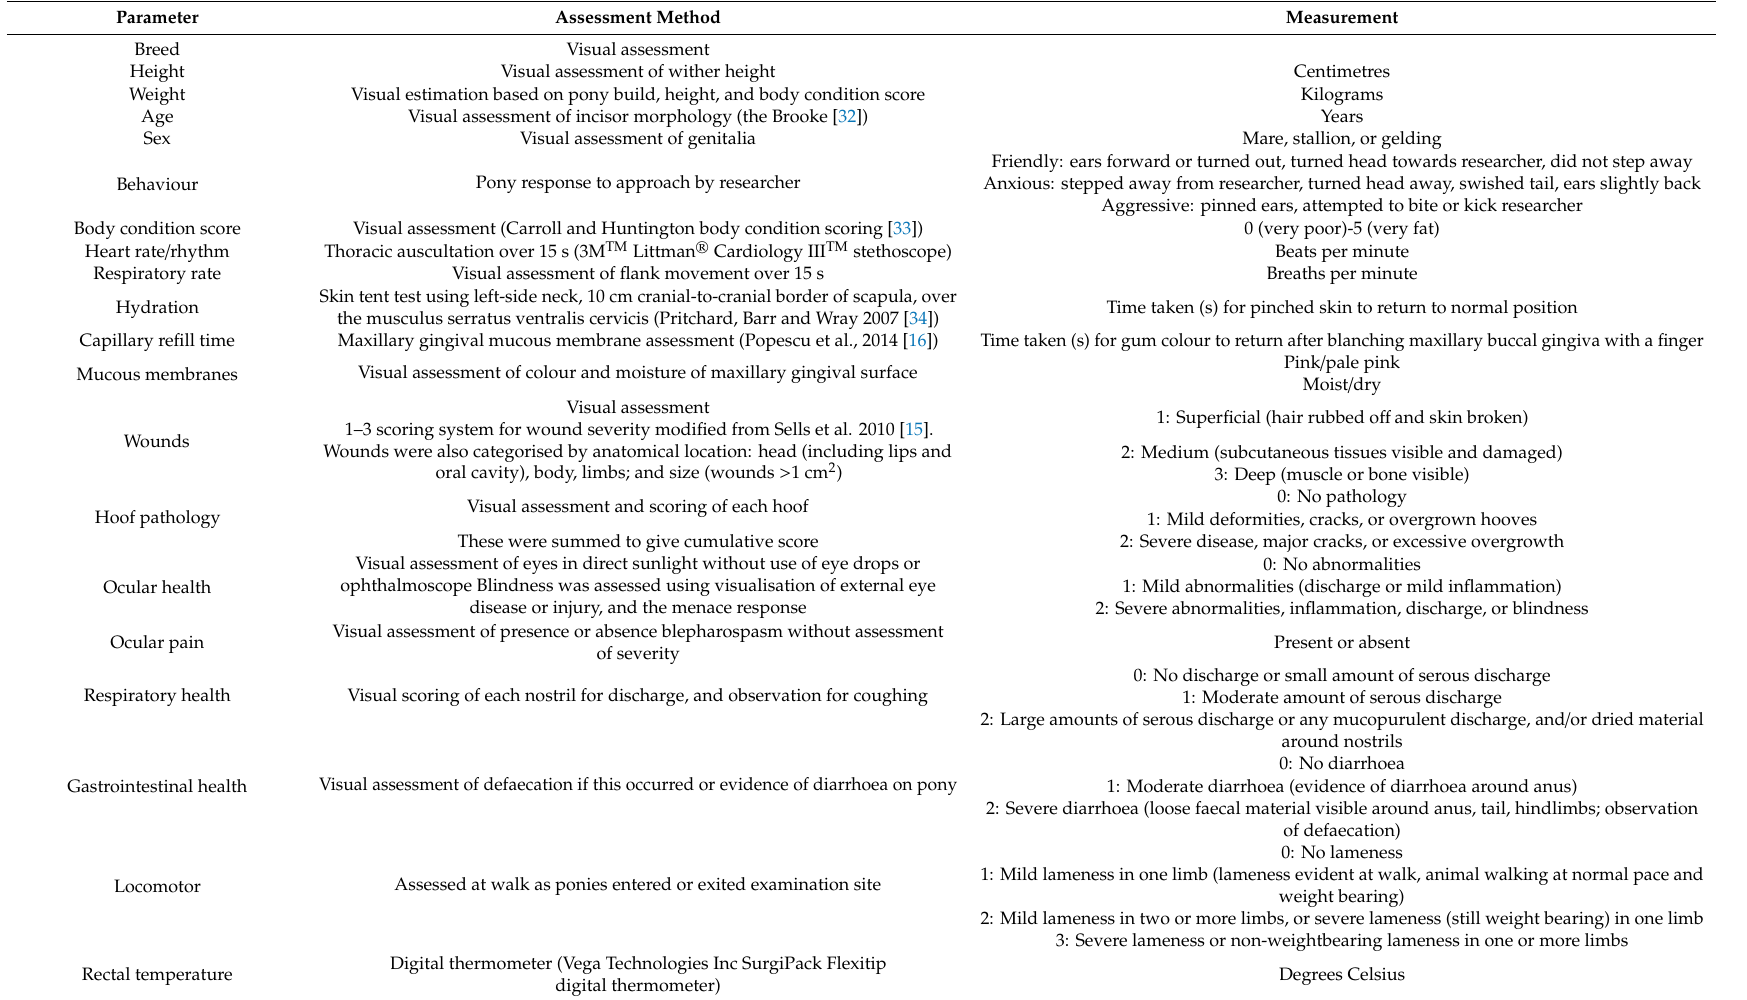
Table 1. Pony health examination parameters, assessment methods, and